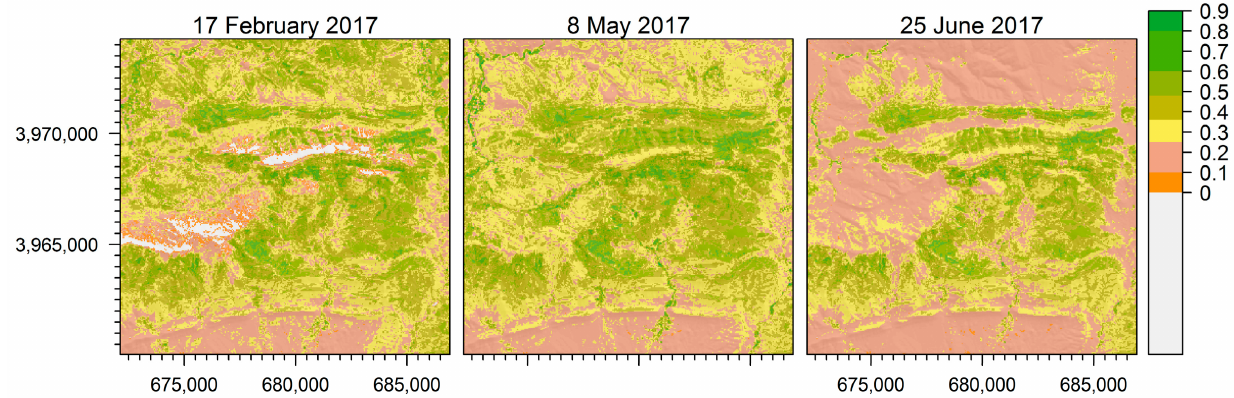
Figure 5. Seasonal changes in NDVI in the Ouled Hann è che Mountains in